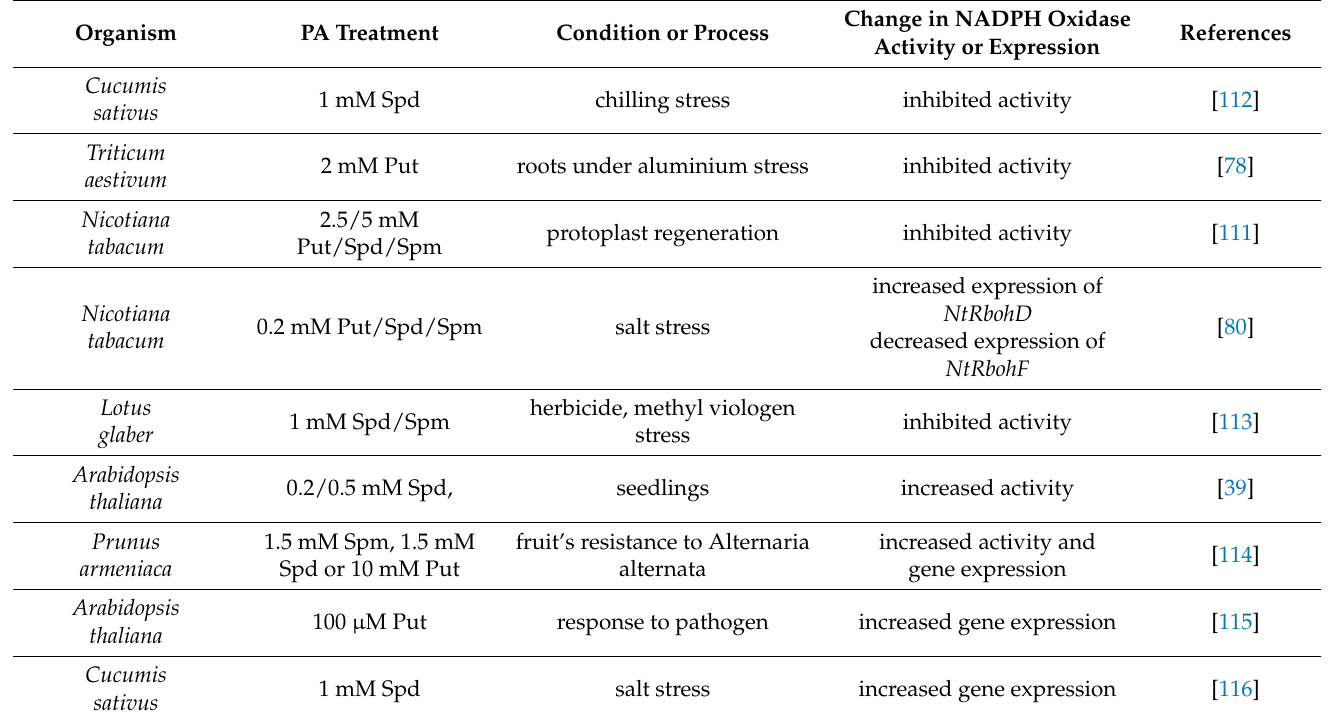
Table 2. The effect of exogenous polyamine application on NADPH oxidase level/activity.